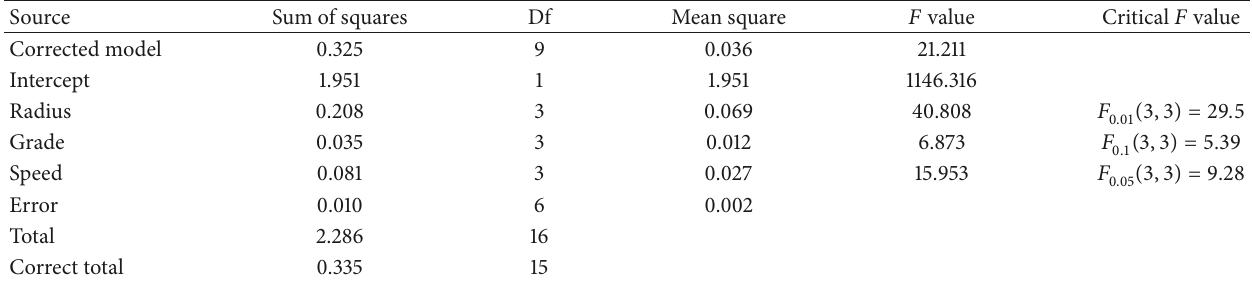
Table 6: Variance analysis of factors influencing 𝑓 𝐷 on curved downgrades.